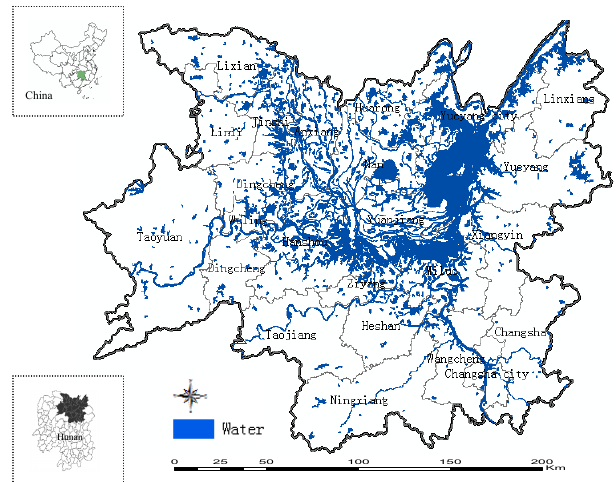
Fig 1 the location and water body distribution of Dongting Lake region Fig. 1. The location and water body distribution of the Dongting Lake